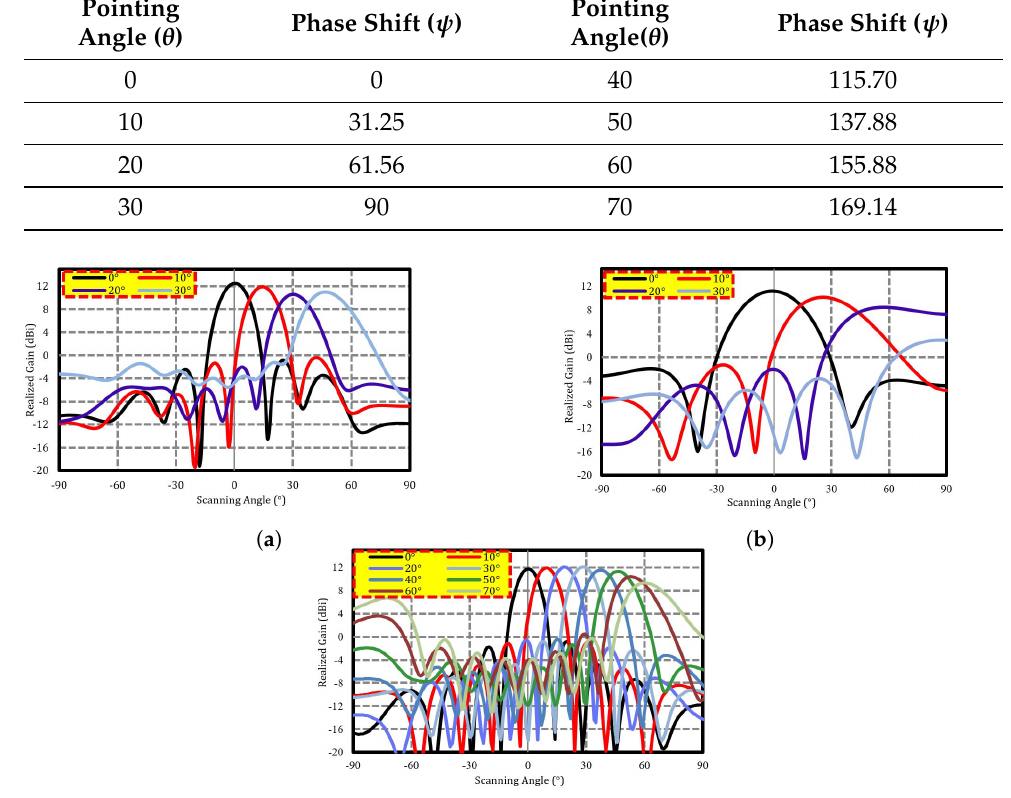
Figure 11. Beamforming in ( a ) straight elements MIMO, ( b ) bend elements MIMO, and ( c ) proposed elements (refer to Figure